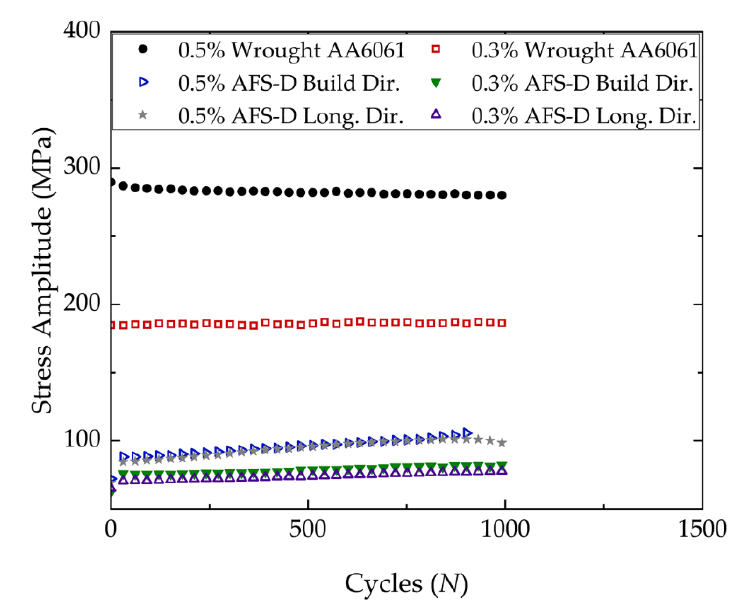
Figure 6. The evolution of the stress amplitude response to deformation for wrought AA6061-T651, as-deposited longitudinal direction AA6061, and as-deposited build direction AA6061 for specimens tested at 0.3 and 0.5%.